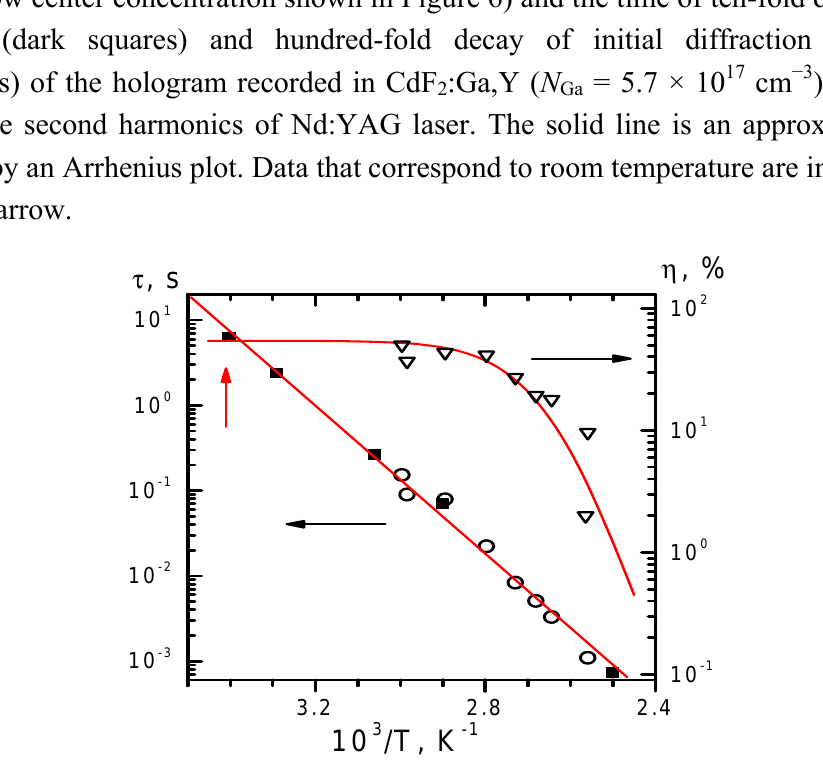
Figure 19. Temperature dependencies of diffraction efficiency (open triangles are experimental data; solid line is the result of calculation based on temperature dependence of the shallow center concentration shown in Figure 5) and the time of hundred-fold decay of initial diffraction efficiency (open circles) of the hologram recorded in CdF = 4 × 10 18 cm − 3 ) crystal by pulses of the ruby laser. The solid line is an approximation ( N In of decay data by an Arrhenius plot. Data that correspond to room temperature are indicated by the vertical